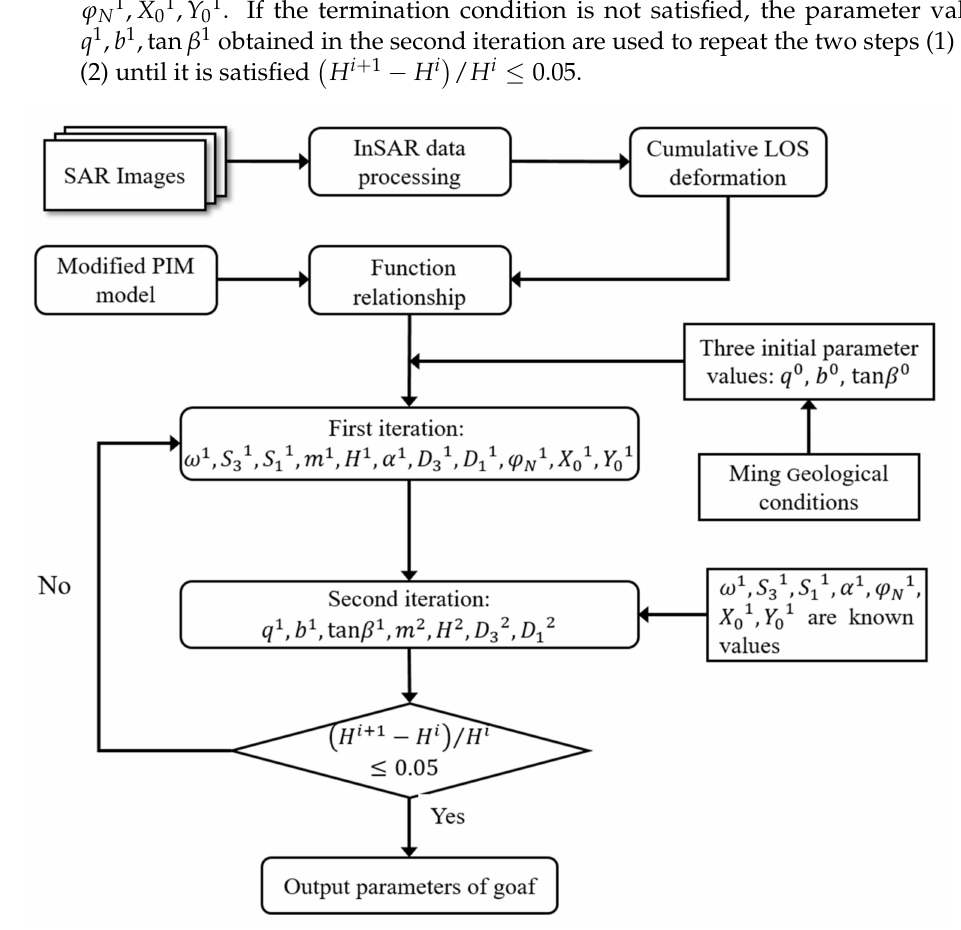
Figure 3. Flowchart of cross-iteration